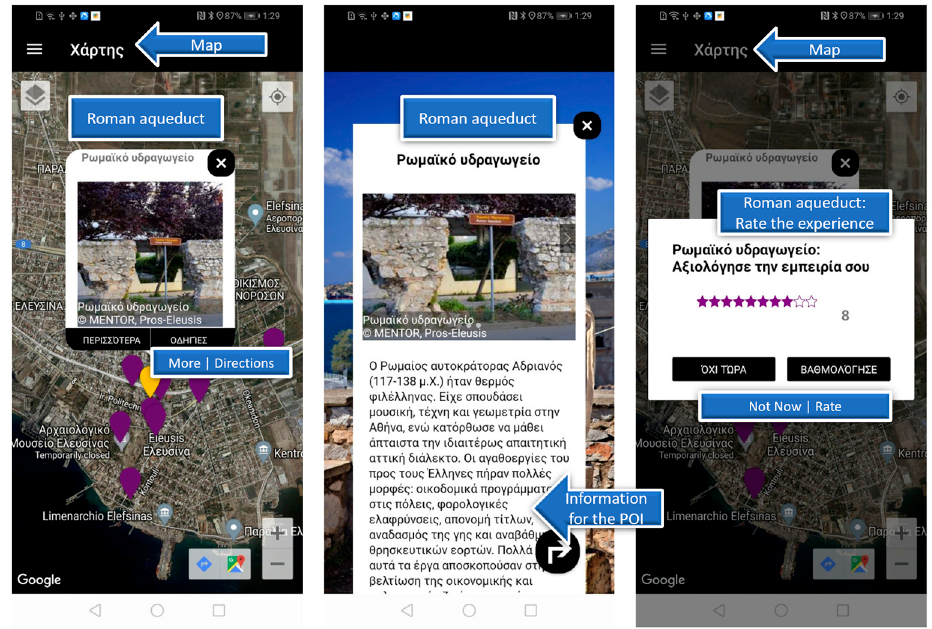
Figure 2. ( Left ) Preview of a POI. ( Middle )The pop-up window showing the content when the POI is selected for viewing. ( Right ) Rating of the POI.